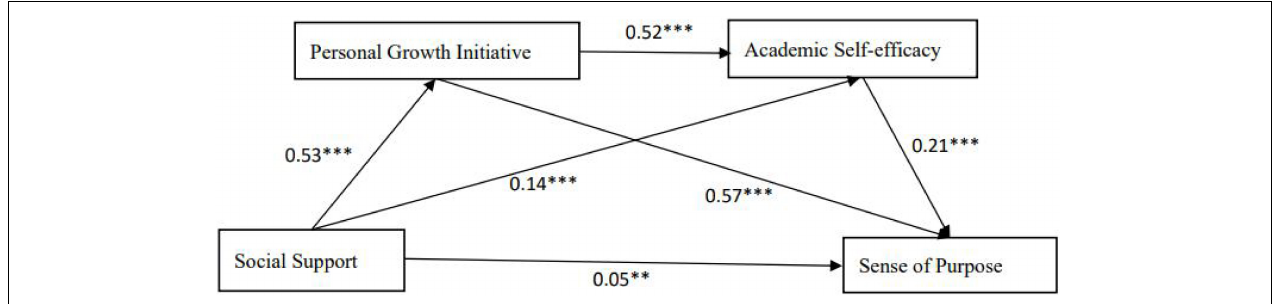
FIGURE 1 | Serial mediation model showing the effects of social support, personal growth initiative, and academic self-efficacy on a sense of purpose. Values shown are unstandardized coefficients. ∗∗ p < 0.01, ∗∗∗ p < 0.001. TABLE 2 | Regression analysis among variables.